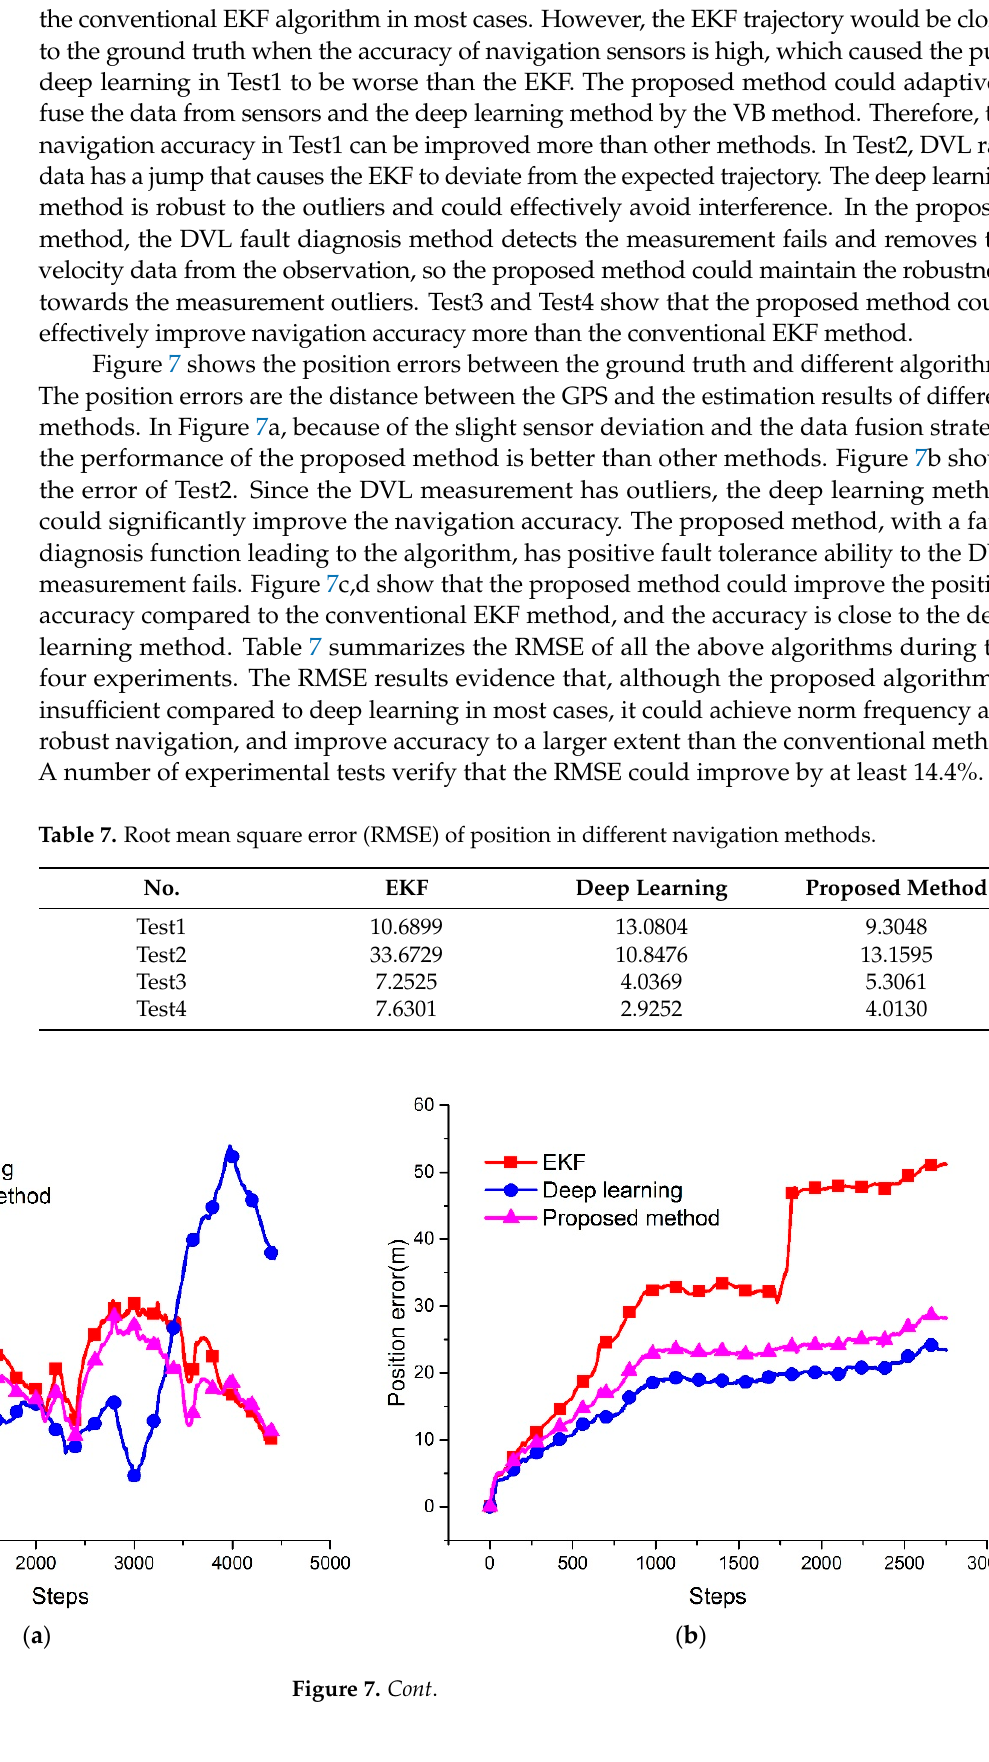
Figure 6. Four experimental results of the ground truth trajectory and the trajectories obtained using different methods based on field